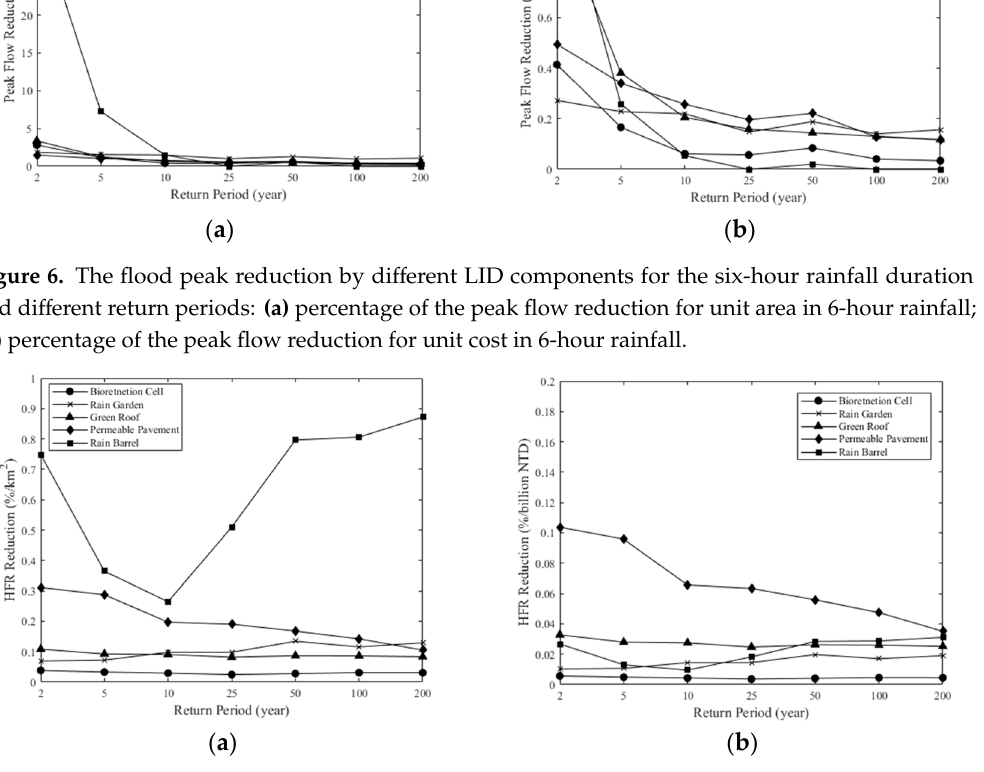
Figure 7. The HFR reduction by different LID components for the six-hour rainfall duration and different return periods: (a) percentage of the HFR reduction for unit area in 6-hour rainfall; ( b ) percentage of the HFR reduction for unit cost in 6-hour rainfall.